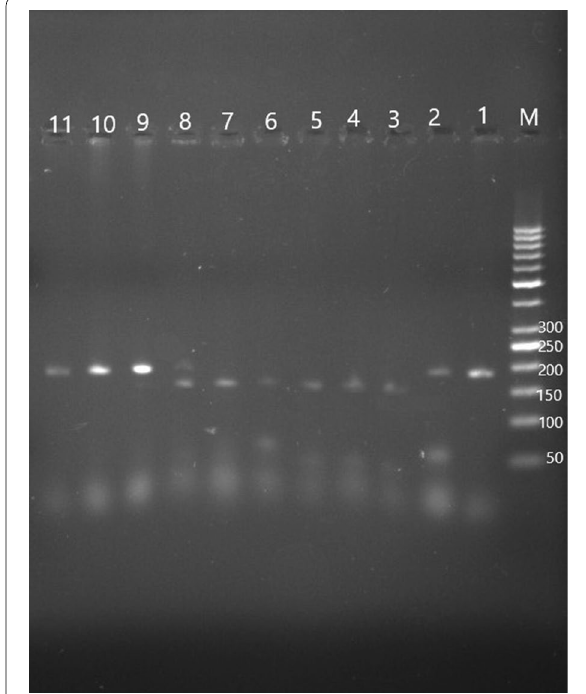
Fig. 1 Digested PCR products of PON1 gene with MboI restriction enzyme. Homozygous AA shows 2 bands at 156 bp and 33 bp, Heterozygous AG shows 3 bands at 189 bp, 156 bp, and 33 bp, and Homozygous GG shows a single undigested band at 189 bp. Lane M is DNA Ladder (50 bp); Lane 3,4,5,6,7 show AA genotype; Lane 8 represents AG genotype; Lane 1,2,9,10,11 are GG genotype